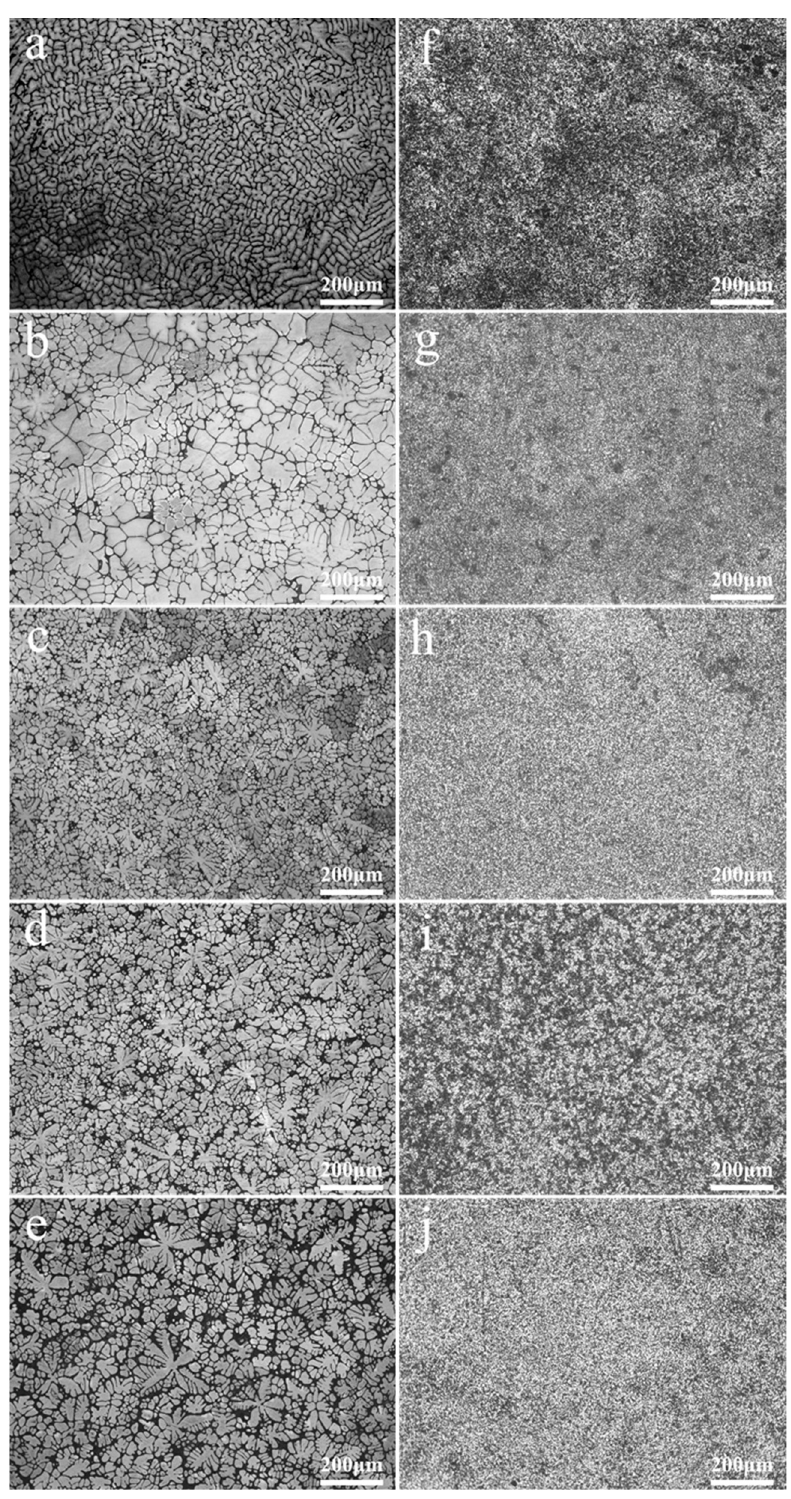
Figure 2. The optical metallographic microstructures of Mg-In-Ca alloys: ( a ) as-cast IC31 alloy, ( b ) as-cast IC32 alloy, ( c ) as-cast IC33 alloy, ( d ) as-cast IC34 alloy, ( e ) as-cast IC35 alloy, ( f ) extruded IC31 alloy, ( g ) extruded IC32 alloy, ( h ) extruded IC33 alloy, ( i ) extruded IC34 alloy, and ( j ) extruded IC35